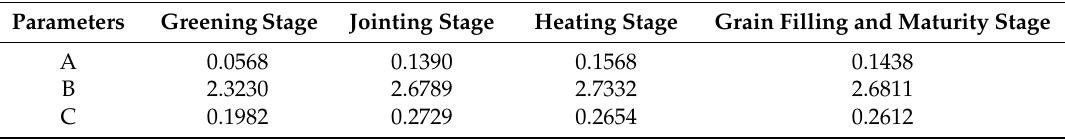
Table 3. Parameters of the root water uptake